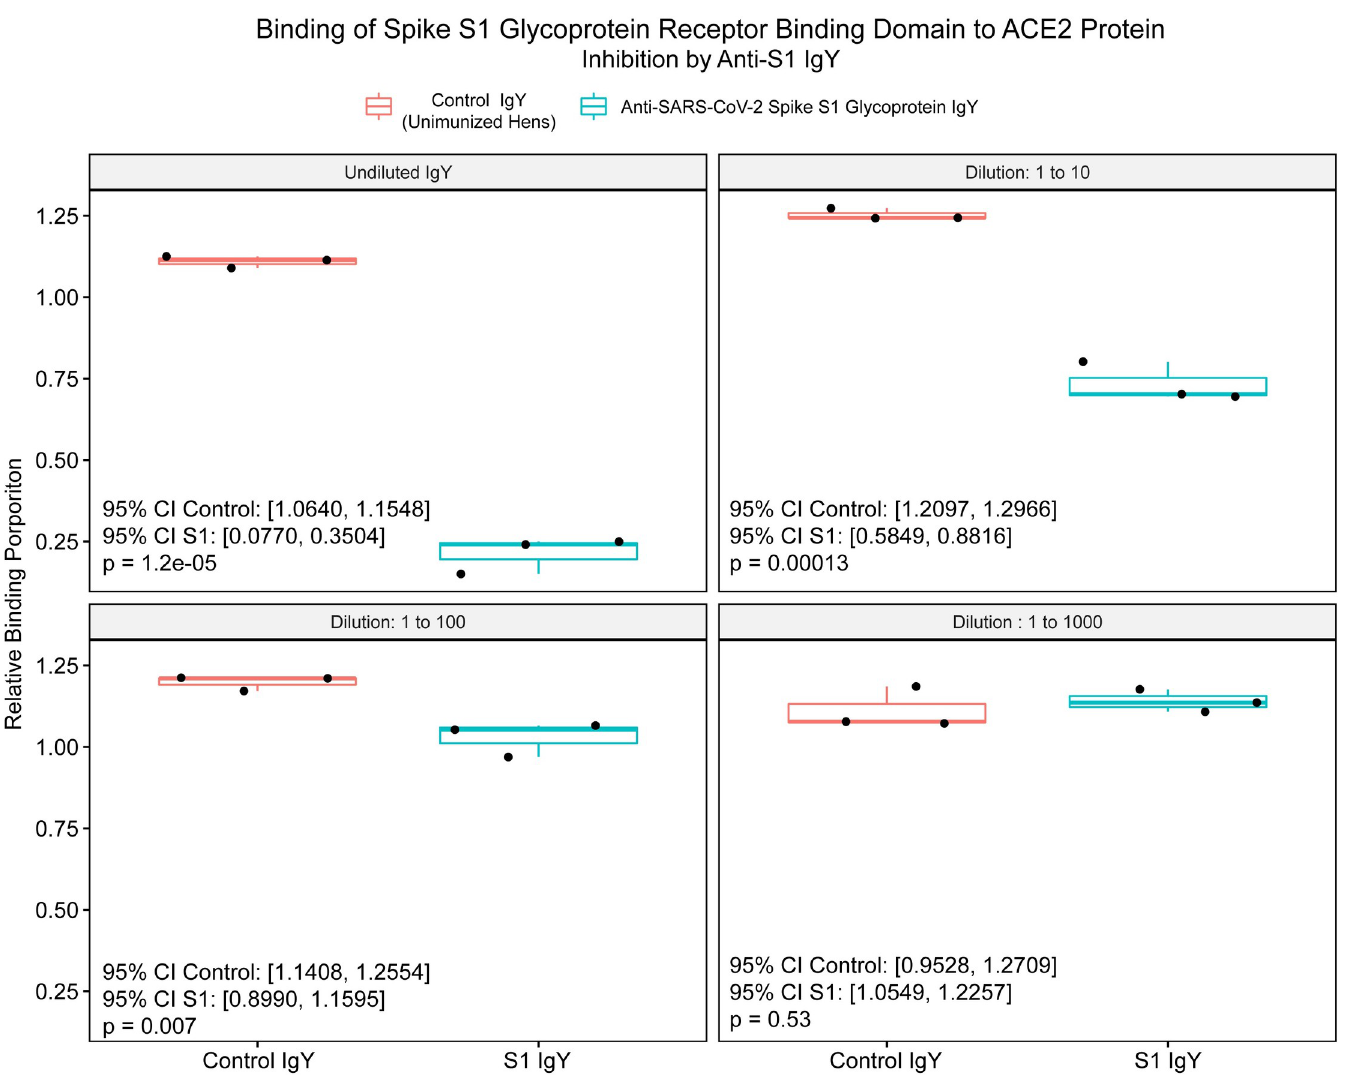
Fig 3. Box and whisker plots of SARS-CoV-2 spike glycoprotein (S1) Receptor Binding Domain (RBD) percent binding to angiotensin converting enzyme-2 protein in a cell-free system. Relative binding proportion (Y-axis) was determined by the kit-provided standard binding inhibitor. Boxes represent interquartile range (IQR) with median shown as center bar of each sample group. Whiskers represent 1.5 times the IQR. P-value, by two-sample t-test method, and 95% confidence interval (CI) was calculated using R software package EnvStats (v.2.3.1). [19] Undiluted (16.8 mg/ml), and logarithmic dilutions (1.68, 0.168, and 0.0168 mg/ml) are